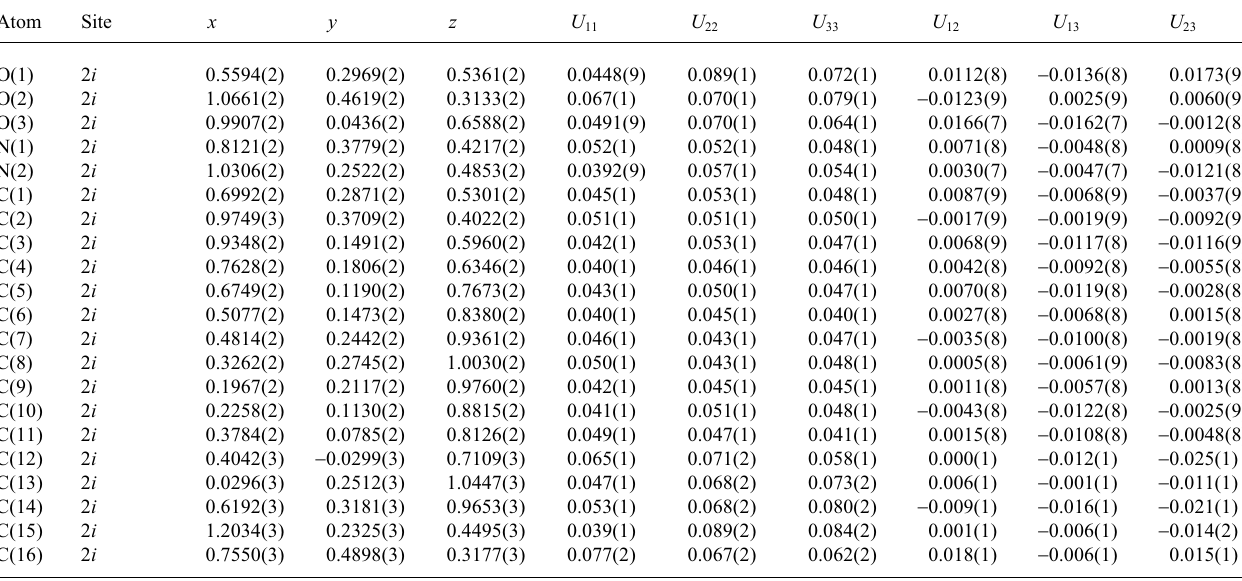
Table 3. Atomic coordinates and displacement parameters (in Å 2 )